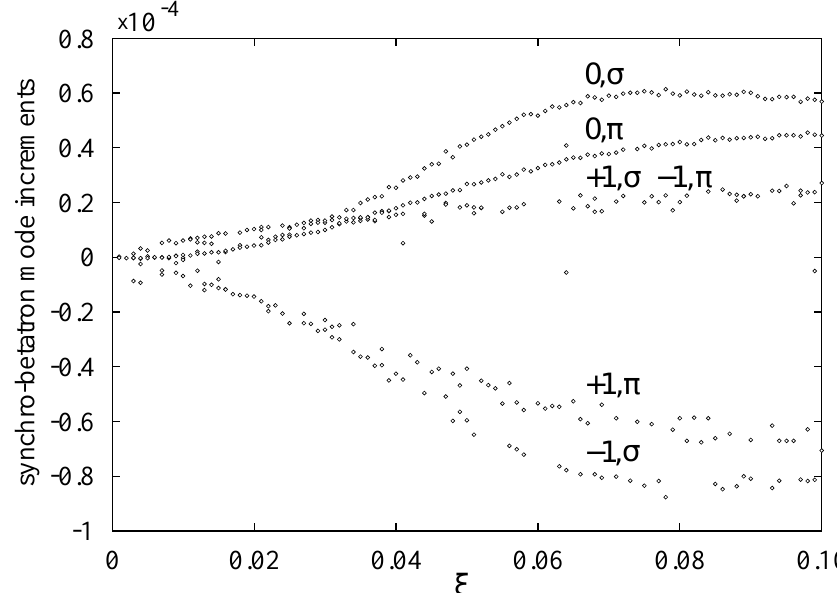
FIG. 7. Synchrobetatron mode increments per turn vs j for combined action of the beam-beam interaction and machine impedance (tracking). Equal bunch intensities, n b (cid:1) 0.11 , n s (cid:1) 0.03 , and the bunch length is 0.7 b (cid:1) . The constant wake, Q (cid:1) 0.005 , corre- sponds to the m (cid:1) 0 mode tuneshift of 2 3 3 10 2 5 (cid:1) 2 10 2 3 n s